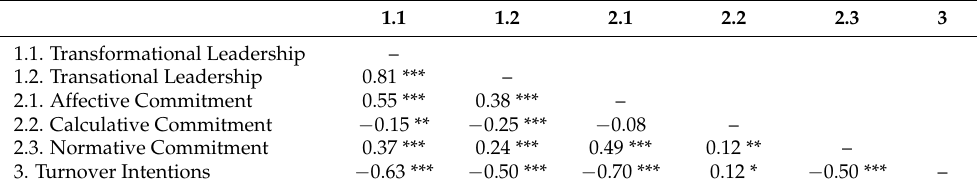
Table 3. Association between the variables under study.